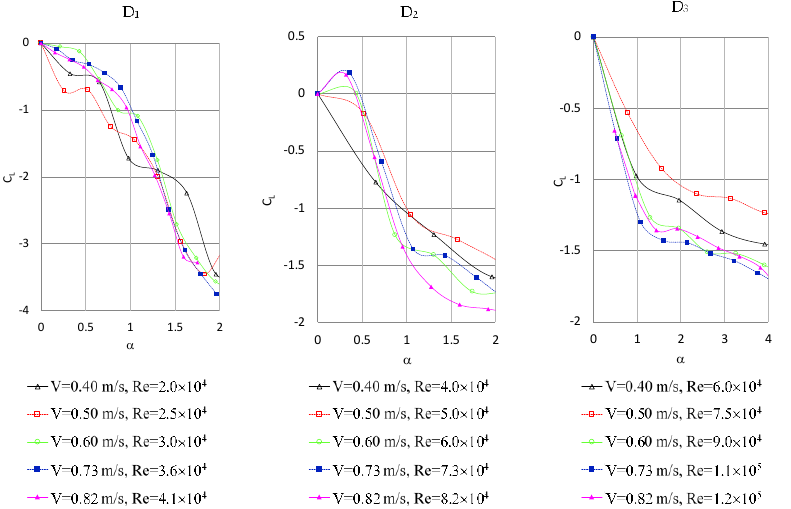
Figure 6. Variation of the lift coefficient with rotation rate for various free stream velocities and various cylinder diameters—experimental